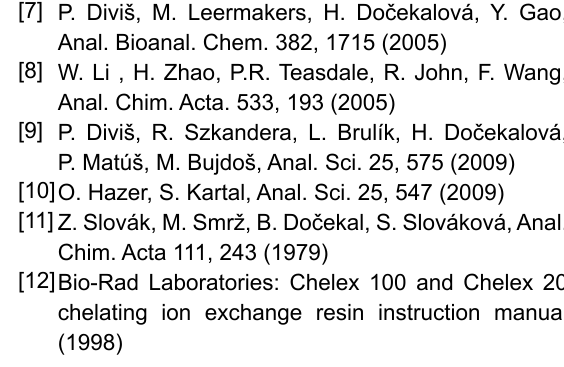
measure lower mercury concentration.